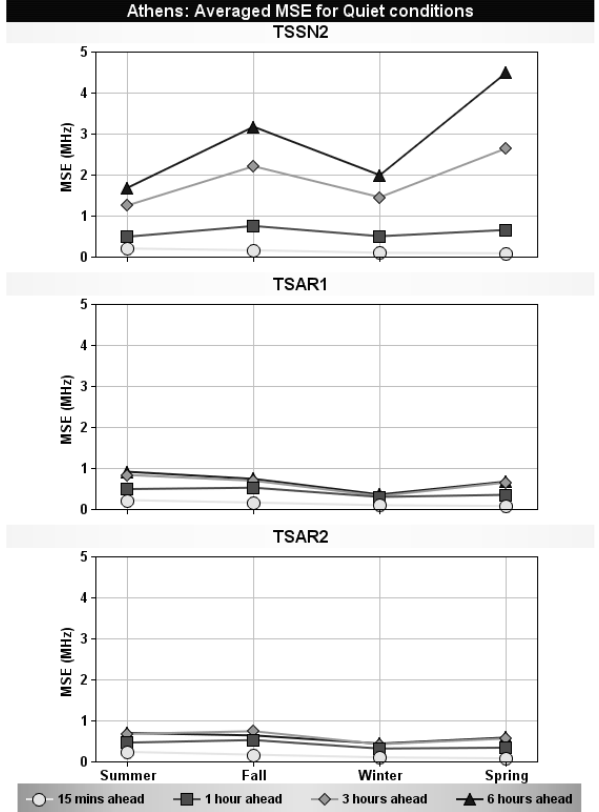
Fig. 7. The average values of the MSE over each season for the quiet intervals listed in Table 1, using the prediction results of the three models TSNN2 (top), TSAR2 (middle), TSAR1 (bottom) for Athens location, for prediction windows 1h, 3h and